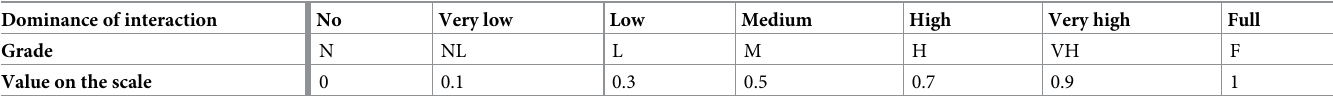
Table 5. Scheme for the degree of perceived dominance factor (adopted from [65]). Dominance of interaction